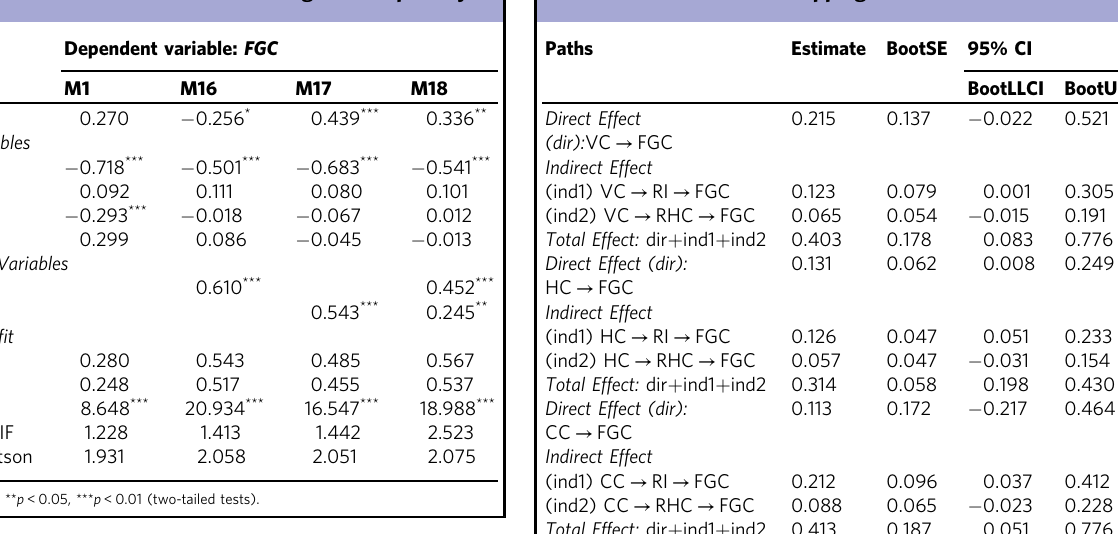
Table 6 Results of bootstrapping test. Table 5 The effects of R&D efforts on fi rm growth